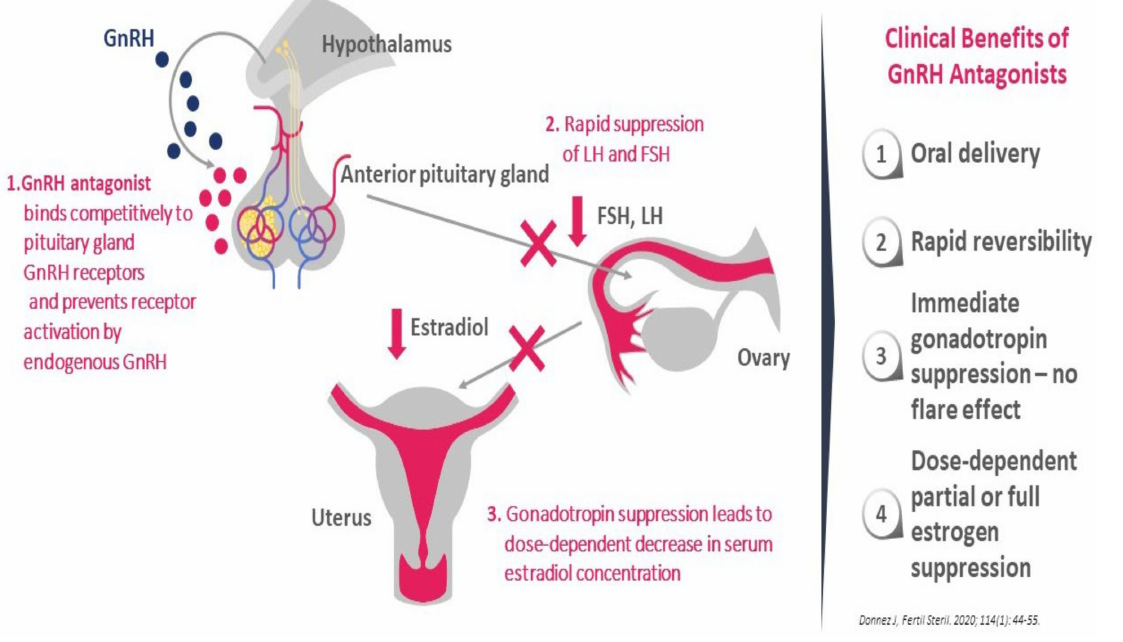
Figure 1. GnRH antagonist mechanism of